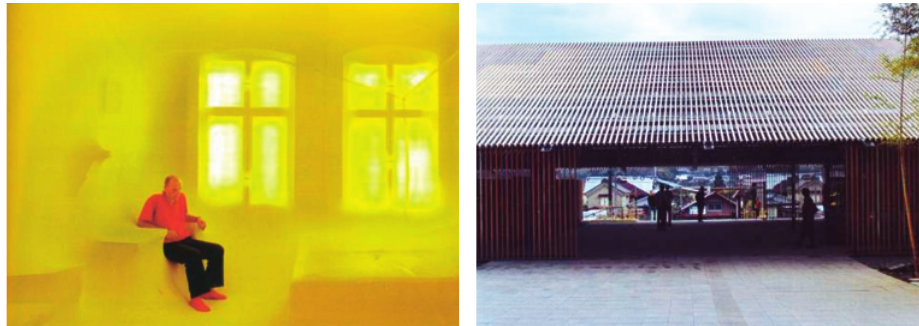
Fig. 4. Kengo Kuma. Nakagawa­machi Bato Fig. 3. Hans Hemmert. Saturday Afternoon